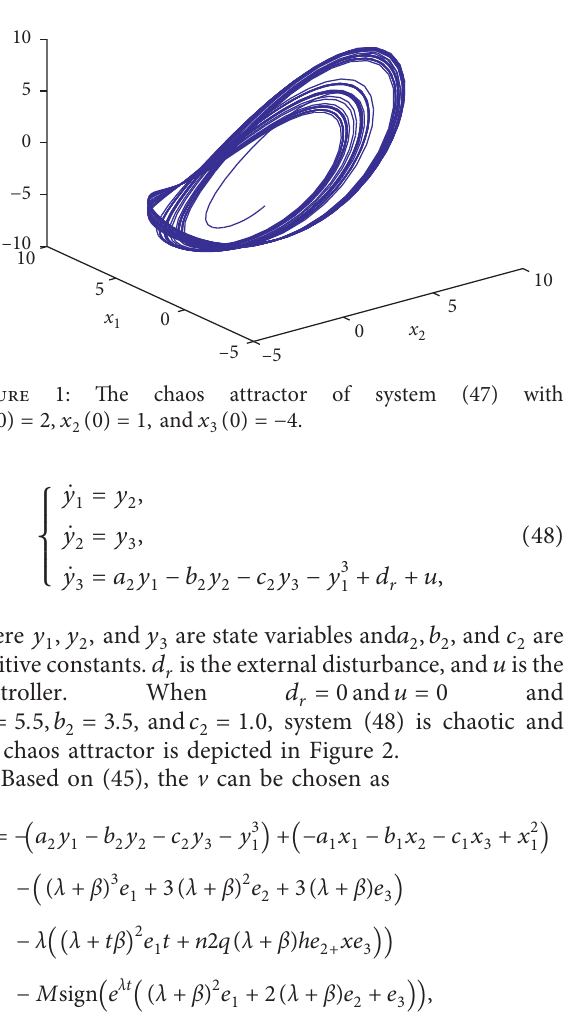
Figure 3: The time response of synchronization error variable e